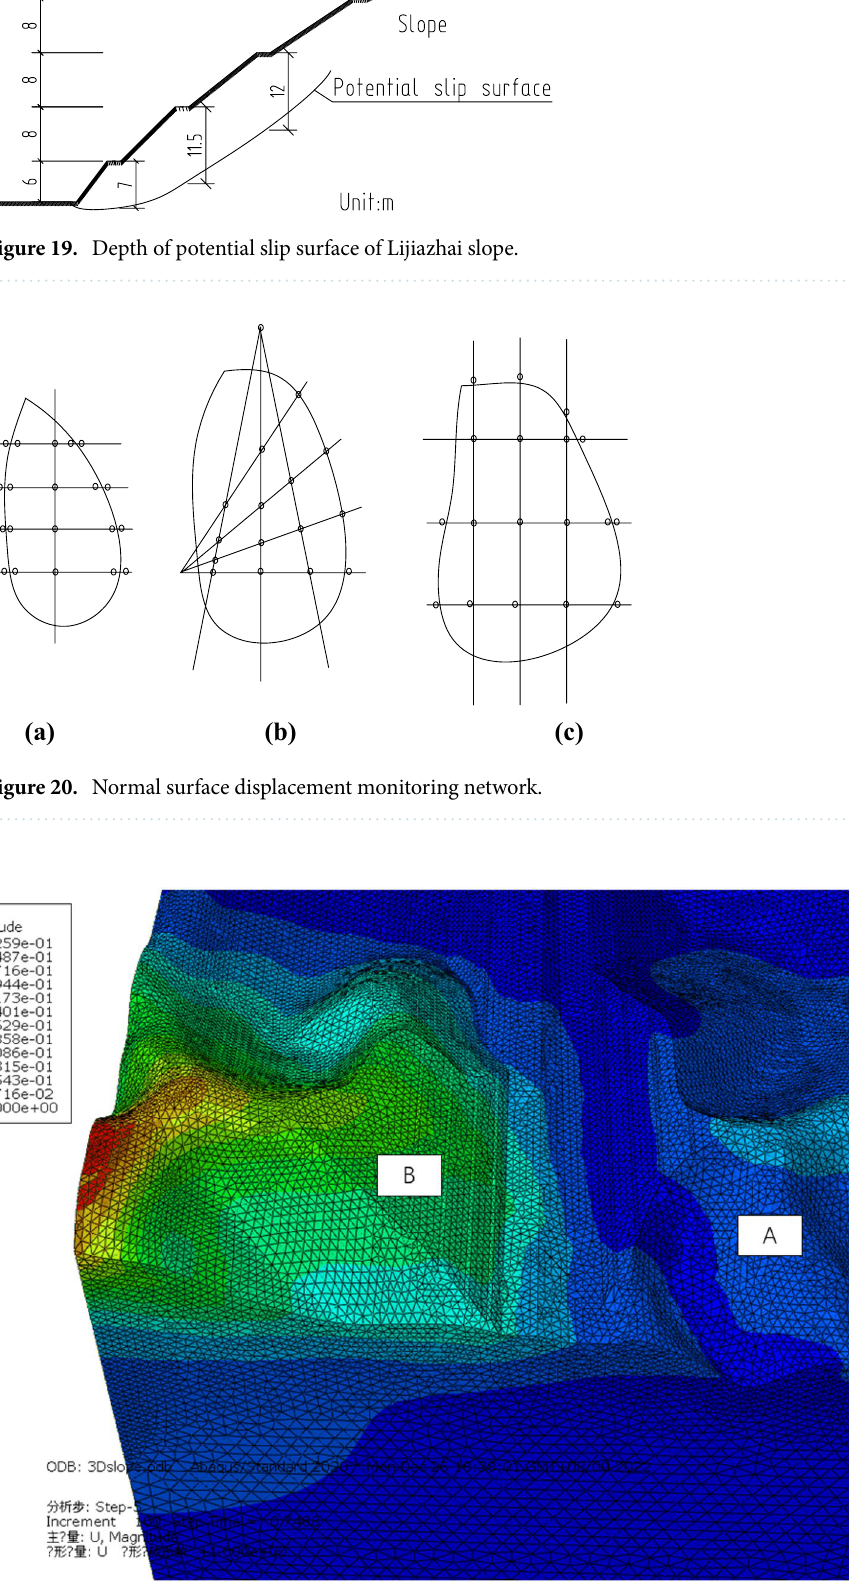
Figure 21. Total displacement of the